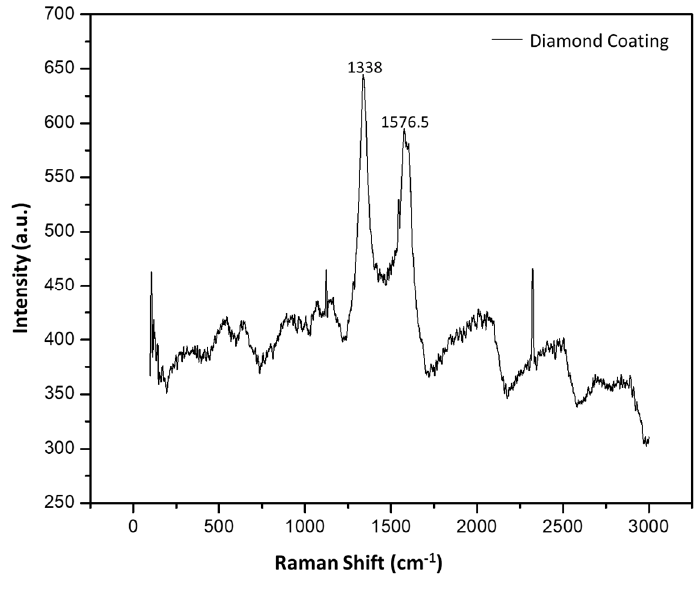
Figure 8. Raman spectra of the DLC-coated tungsten carbide tool inserts .